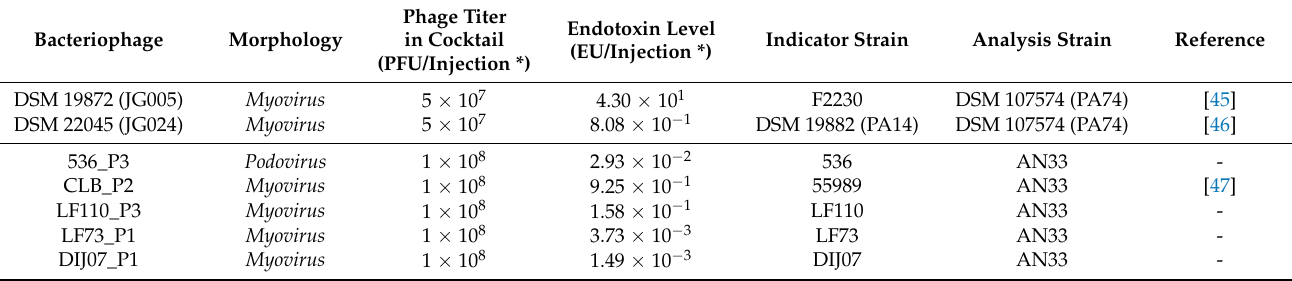
Table 1. Phages used in this